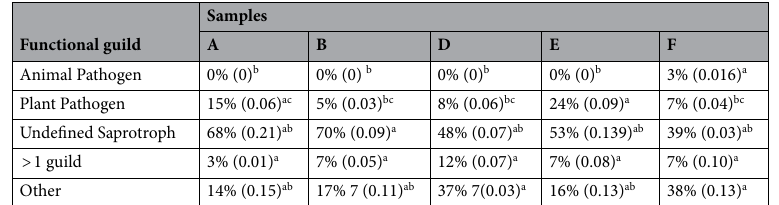
Table 1. Relative richness of the most abundant functional guilds (> 1% in at least one sample) among samples reported as mean (SD). Different letters after the SD indicate significance at p < 0.05 (Tukey post hoc test).